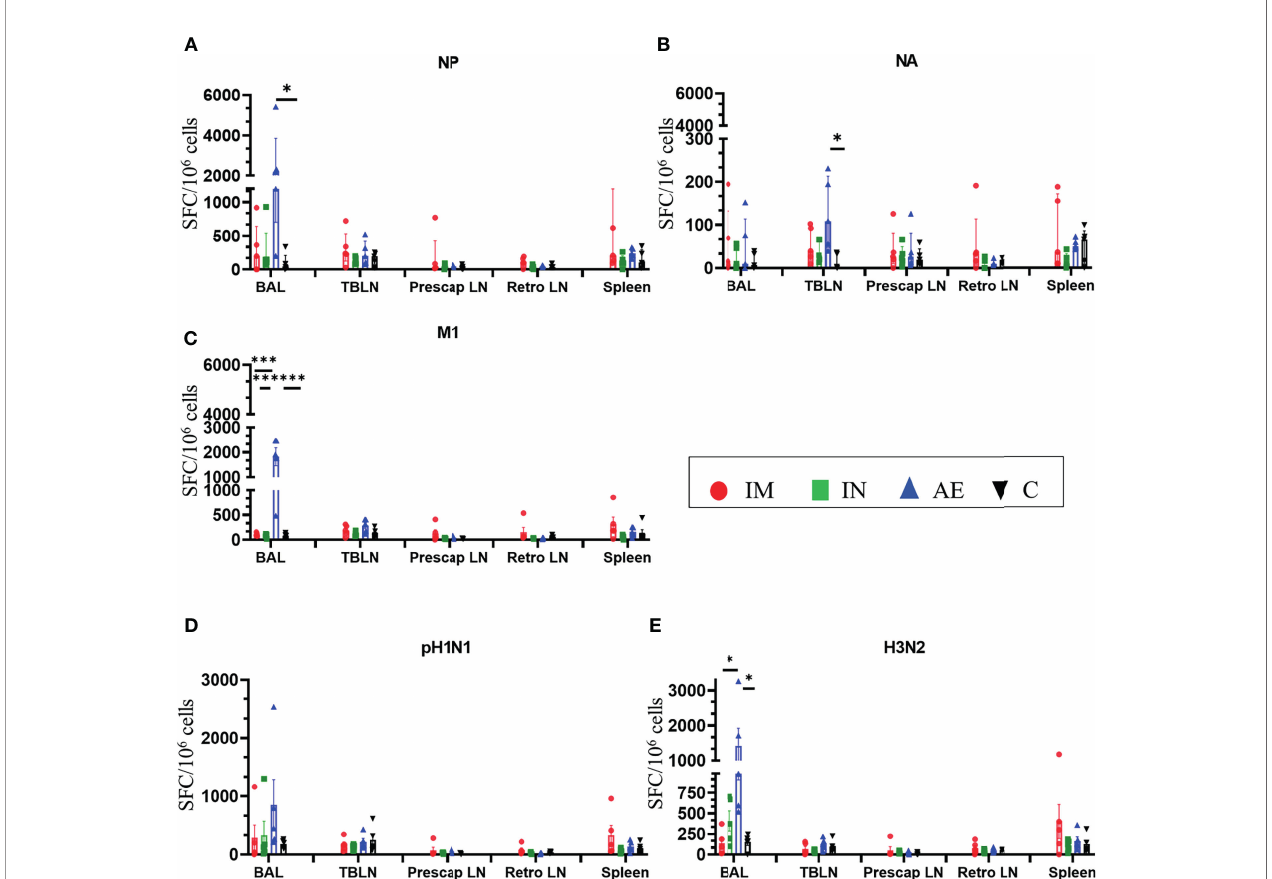
FIGURE 4 | IFN g ELISpot responses in tissues. IFN g secreting spot-forming cells (SFC) were enumerated in BAL, tracheobronchial lymph nodes (TBLN), prescapular lymph nodes (prescap LN), retropharyngeal lymph nodes (retro LN), and spleen on D56. Cells from tissues were stimulated with a pool of peptides covering (A) NP, (B) M1, and (C) NA proteins or (D) pH1N1 and (E) H3N2 viruses. Each symbol represents an individual animal. For graphs (A) and (B) , Kruskal – Wallis and Dunn ’ s multiple comparisons tests were performed, and the top of these bars indicates the median and the line the interquartile range. The rest of the graphs were analyzed by one-way ANOVA and Bonferroni ’ s multiple comparisons test, and the top of the bar indicates the mean and the line the standard error (SEM). Asterisks denote signi fi cance between indicated groups (* p < 0.05, *** p <